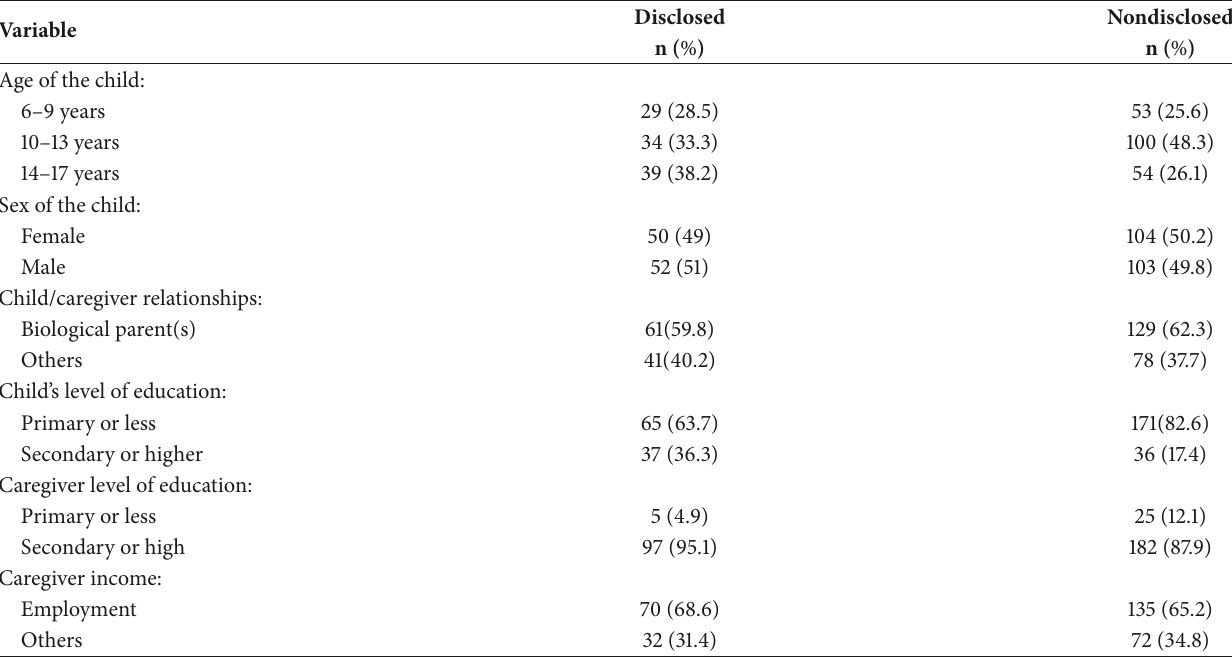
Table 1: Distribution of study participants by sociodemographic characteristics (N=309).